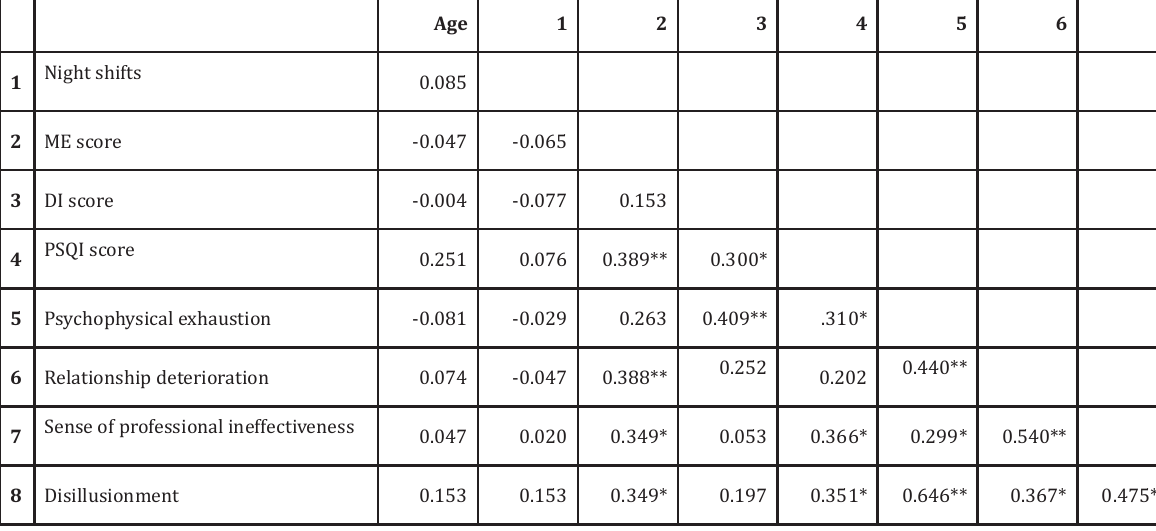
Table 2. Pearson correlation quotients presenting the association between the variables of interest.